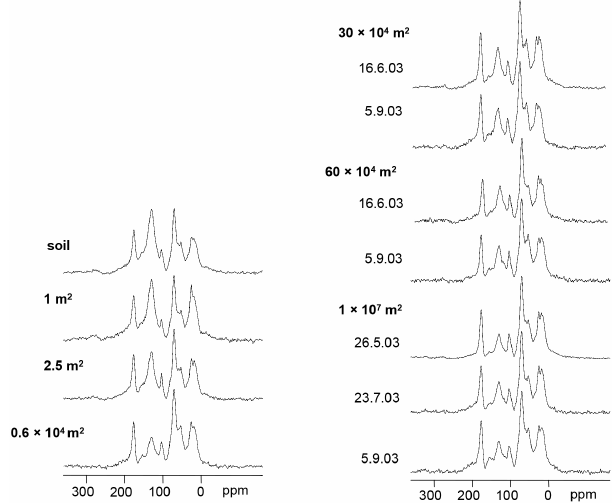
Figure 4. Chemical composition of OC in the upper mineral soil as well as EOM collected after rainfall events at different scales as seen by 13C CPMAS NMR spectroscopy. Note that at three scales sediments sampled at several dates throughout the rainy season were